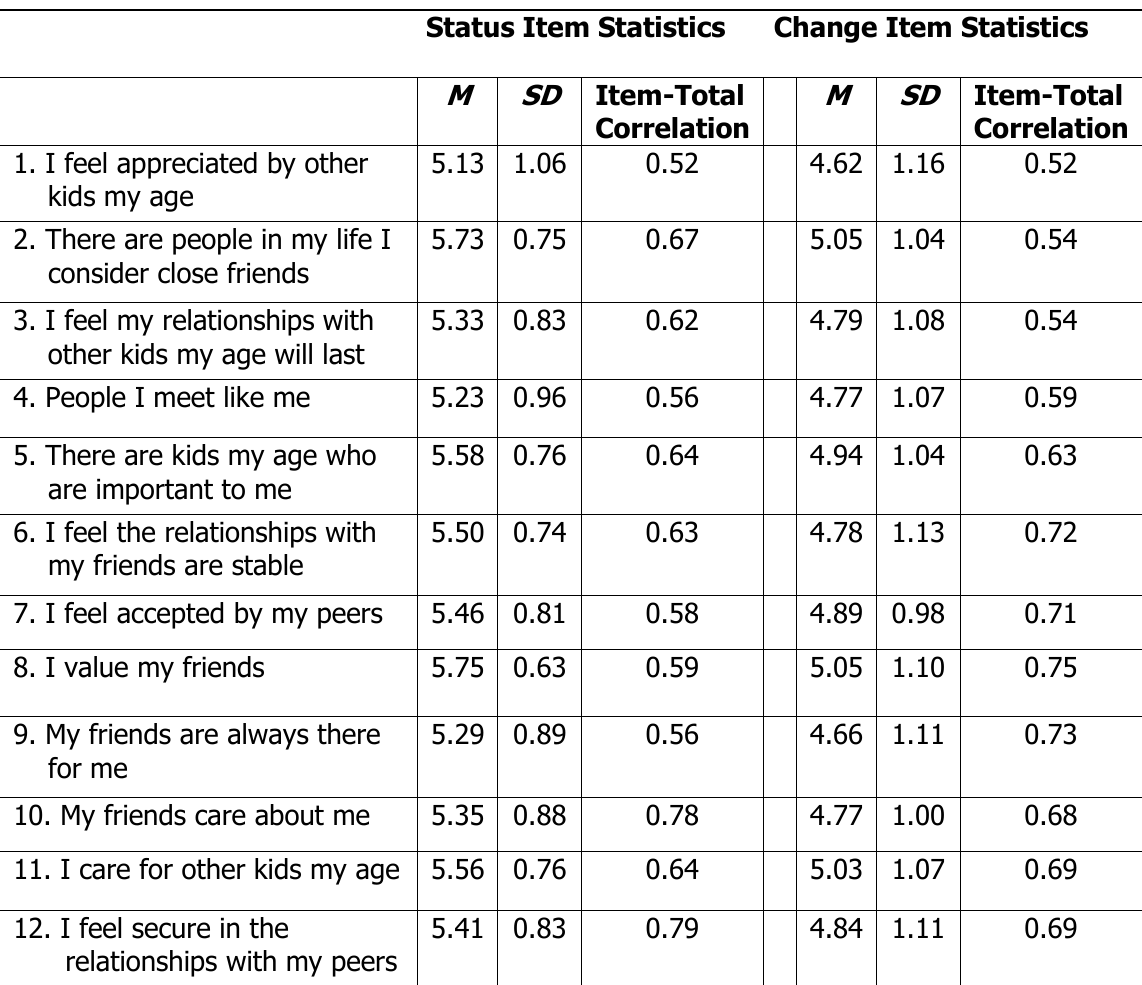
Descriptive Statistics for Initial Item